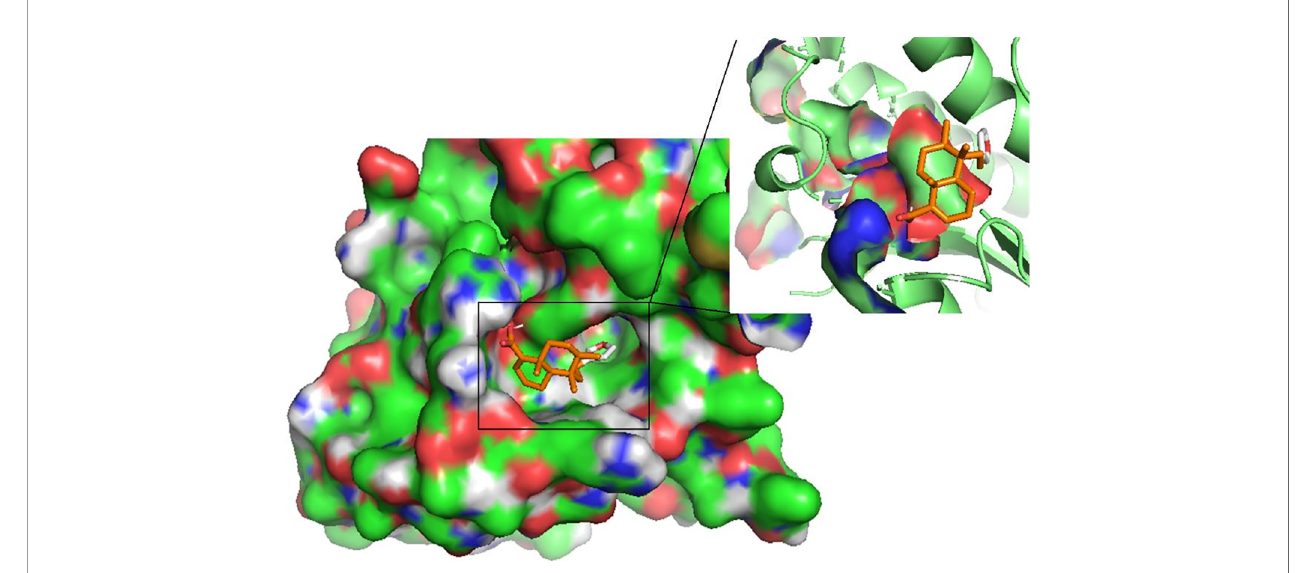
FIGURE 5 | The pose of hardwickiic acid within the binding cavity of Ld PTR1. The receptor is represented as a surface while hardwickiic acid as sticks.